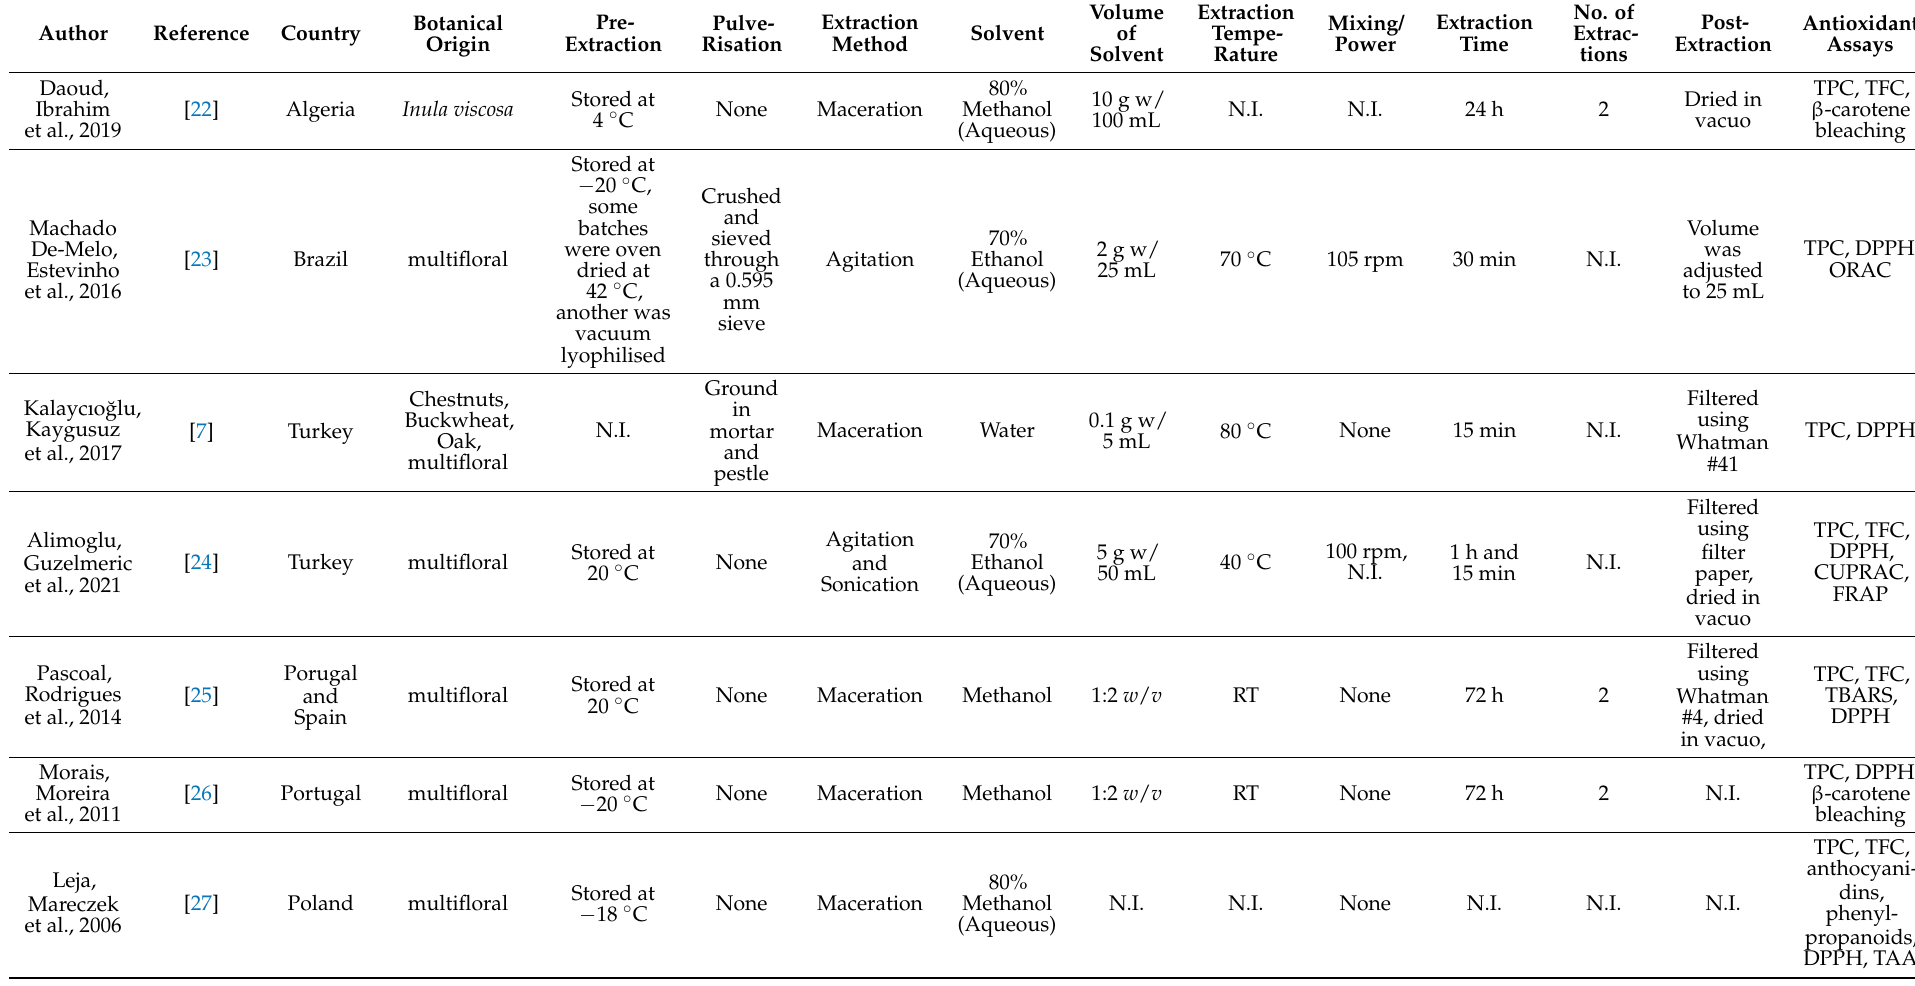
Table 1. Summary of extraction parameters used to determine the antioxidant activity of bee